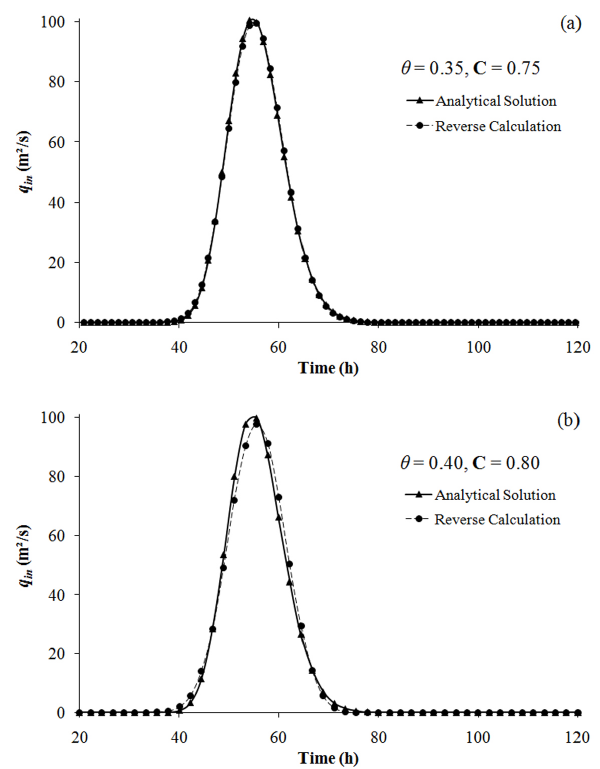
Fig. 4. Single-peak inflow hydrograph recovered through reverse routing from perfect outflow data at x = 200km with grids: C = 0 . 75, θ = 0 . 35 (near-optimal) and C = 0 . 8, θ = 0 . 4 (non-optimal); the analytical inflow is also shown for